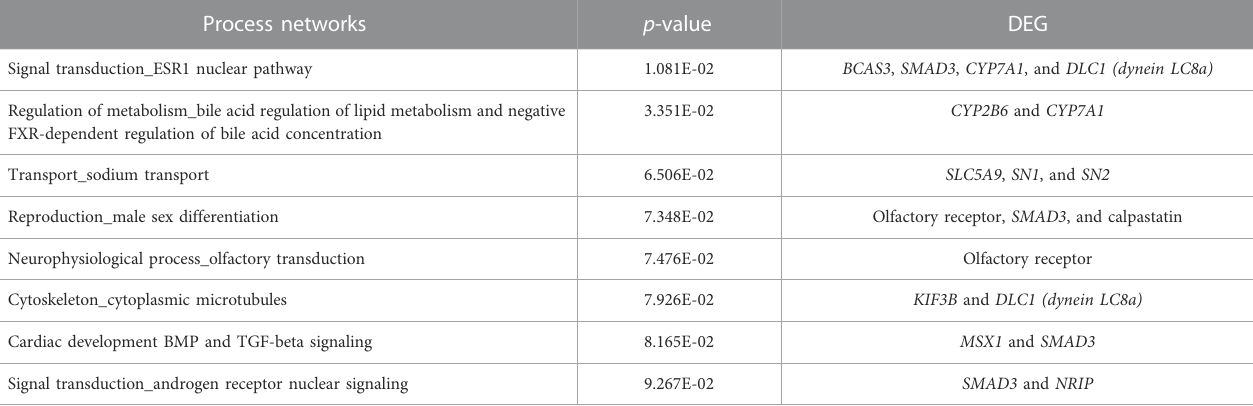
TABLE 5 Process networks from the list of differentially expressed genes (FDR 10%) in the liver tissue of male pigs fed with different oil sources found using MetaCore software ( p -value <